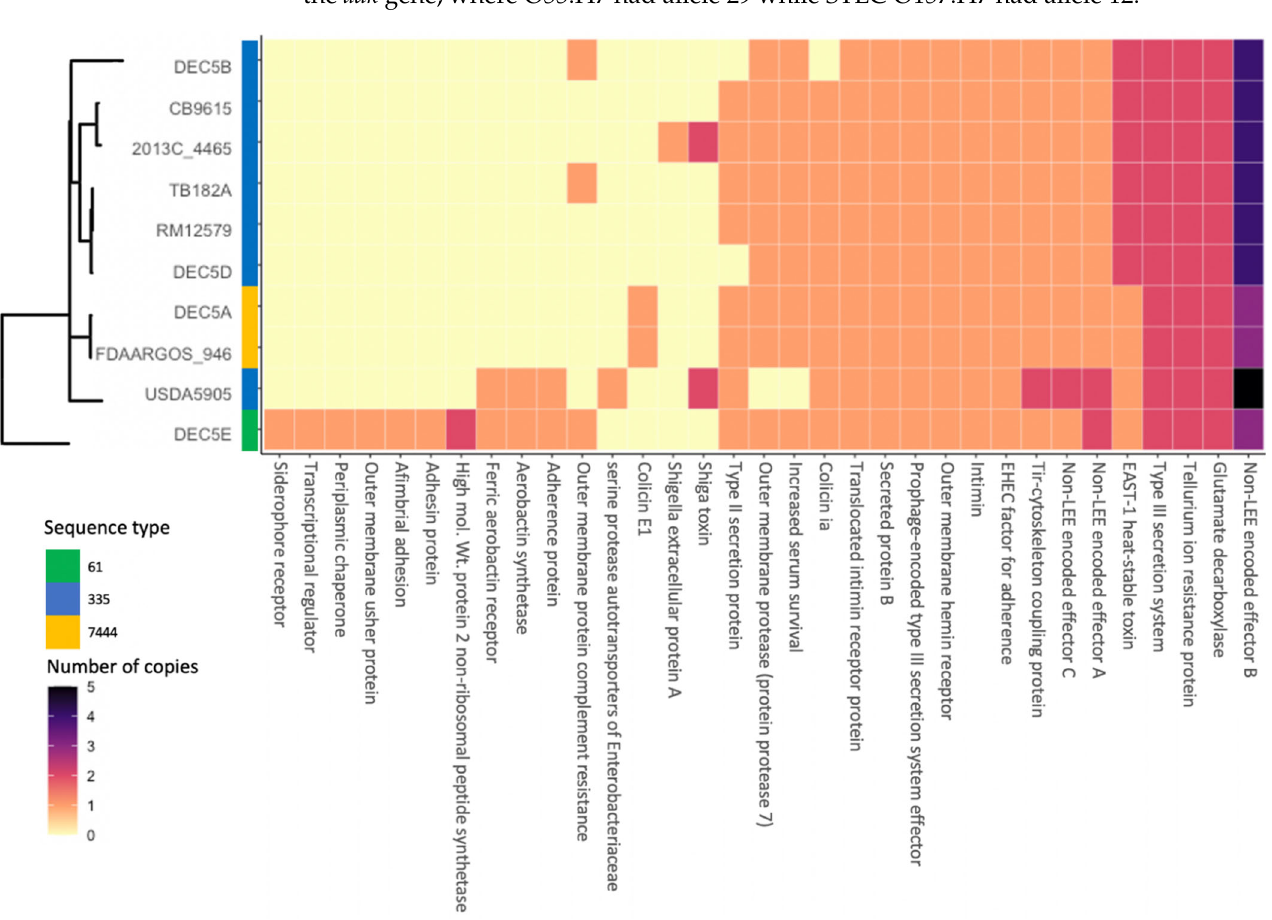
Figure 2. Comparison of the phylogeny of O55:H7 strain with sequence type and virulence gene content. The phylogenomic tree, strain names, and sequence type are on the y axis of the heatmap while the virulence factors are on the x axis. The number of copies of a virulence factor is represented by a different color. The phylogenomic tree is the same as Figure 1.